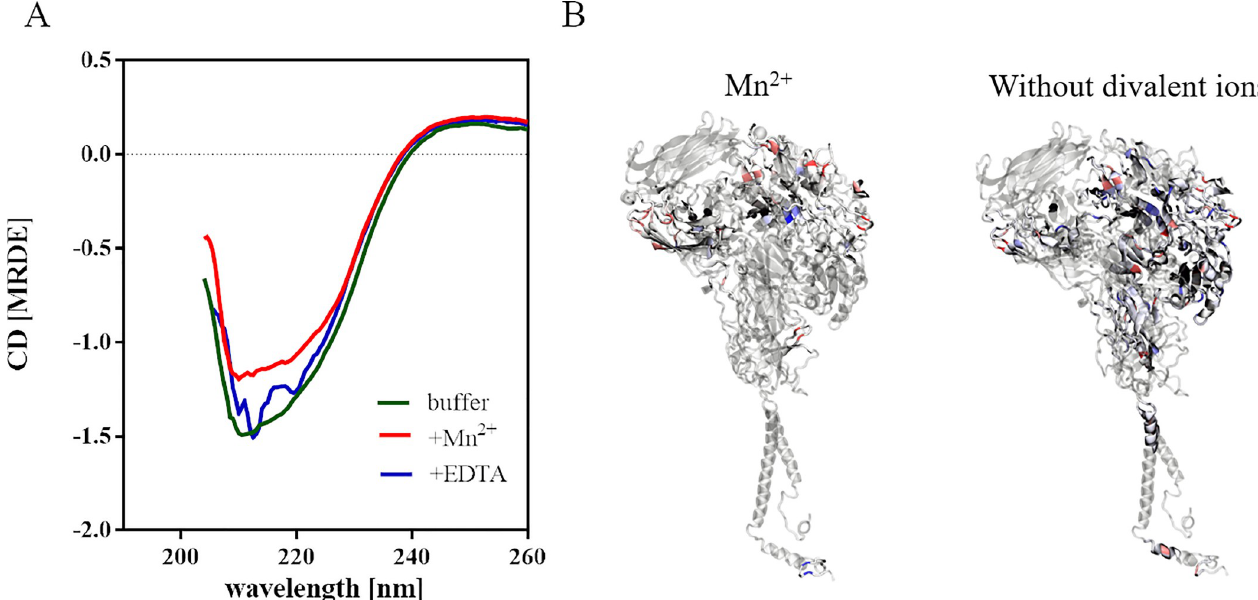
Fig 4. CD spectra and MDS of α IIb β 3. A) Far-UV region CD spectra of α IIb β 3 reconstituted into liposomes in buffer (green), with addition of 1 mM Mn 2+ (red) or 5 mM EDTA (blue). One representative spectrum recorded with proteoliposomes with a protein concentration of approximately 0.4 μ M or liposomes in 5 mm path length cuvettes at 37˚C is shown. Liposome spectra were subtracted from the respective proteoliposome spectra. B) MDS demonstrating the regions that changed drastically in the antiparallel β -sheet probability after removing all structural ions (right) or converting the three Ca 2+ in the MIDAS, ADMIDAS and SyMBS to Mn 2+ (left). The red and blue colored regions illustrate the formation or loss of β -sheets, respectively, compared to integrin with Ca 2+ and Mg 2+ metal ions only. In white or transparent regions, the β -sheet probability did not change.